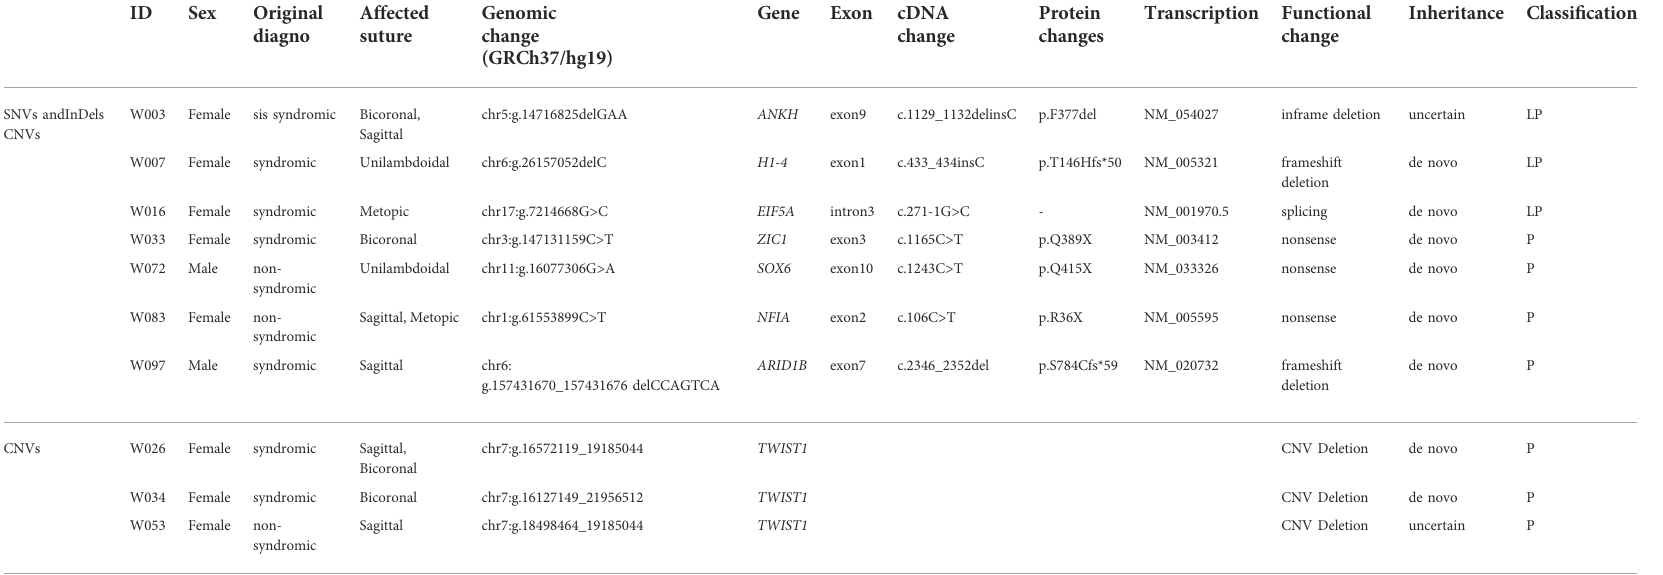
TABLE 2 Pathogenic/likely pathogenic (P/LP) Variants identi fi ed by the CMM